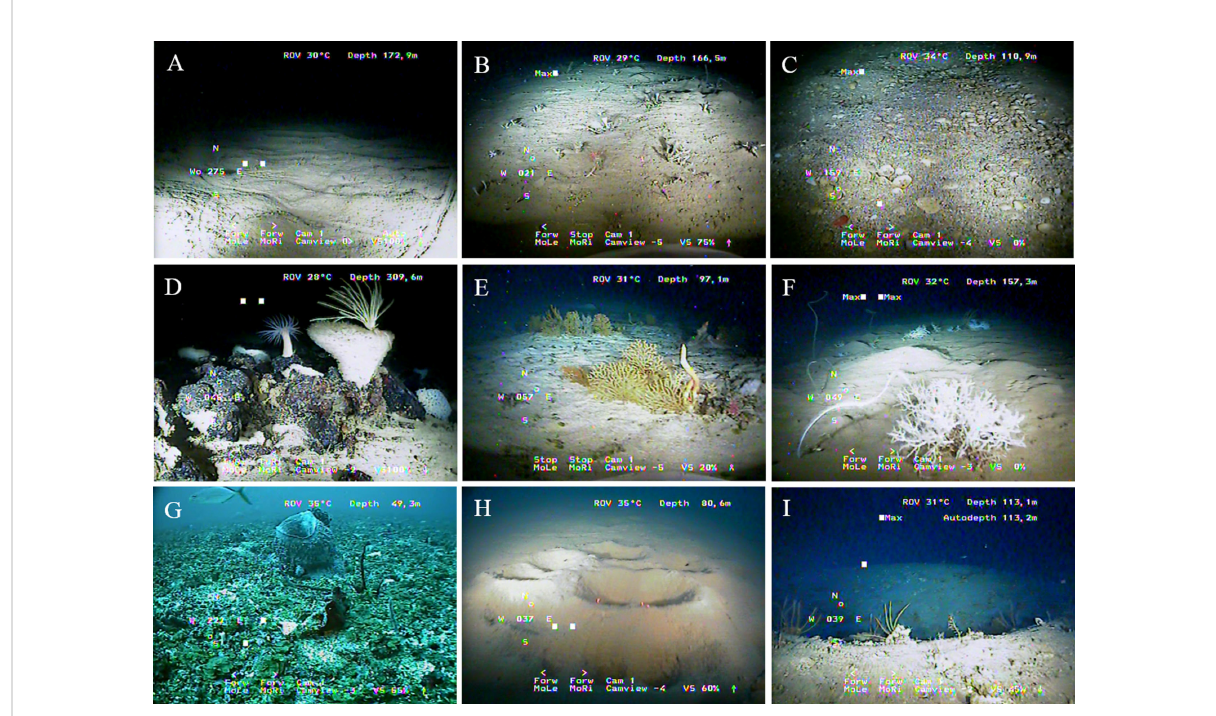
FIGURE 2 Deep-sea macrohabitats from the Corales de Profundidad National Natural Park (Modi fi ed from Partyka et al., 2007). (A) Soft substrate (mud/ sand). (B) Soft substrate/rubble/rock with solitary corals. (C) Coral and shell rubble. (D) Rock/ledges with attached fauna. (E) Rugged stones with attached fauna. (F) Hard substrate with attached fauna. (G) Sandstone with attached fauna. (H) Soft substrate with burrows. (I) Pockmark with attached